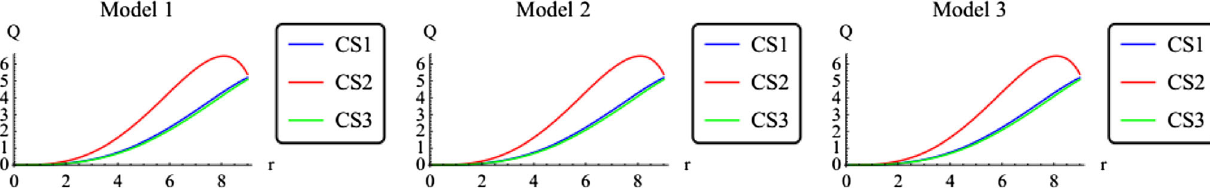
Fig. 19 Variations of electric charge Q with respect to the